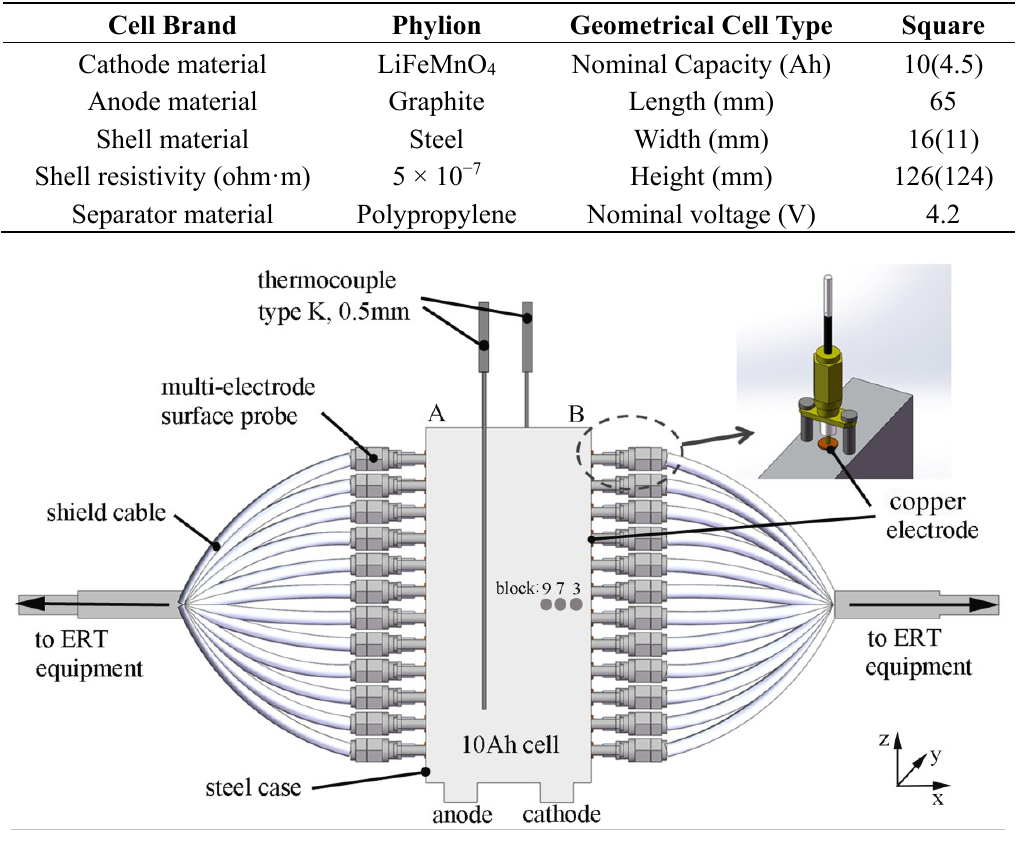
Figure 5. Experimental set-up to apply a multi-electrode resistivity probe on the used 10 Ah cell connected by shield cables. Surface temperatures on top and bottom of the cell are measured with thermocouples type K from the temperature-inspecting